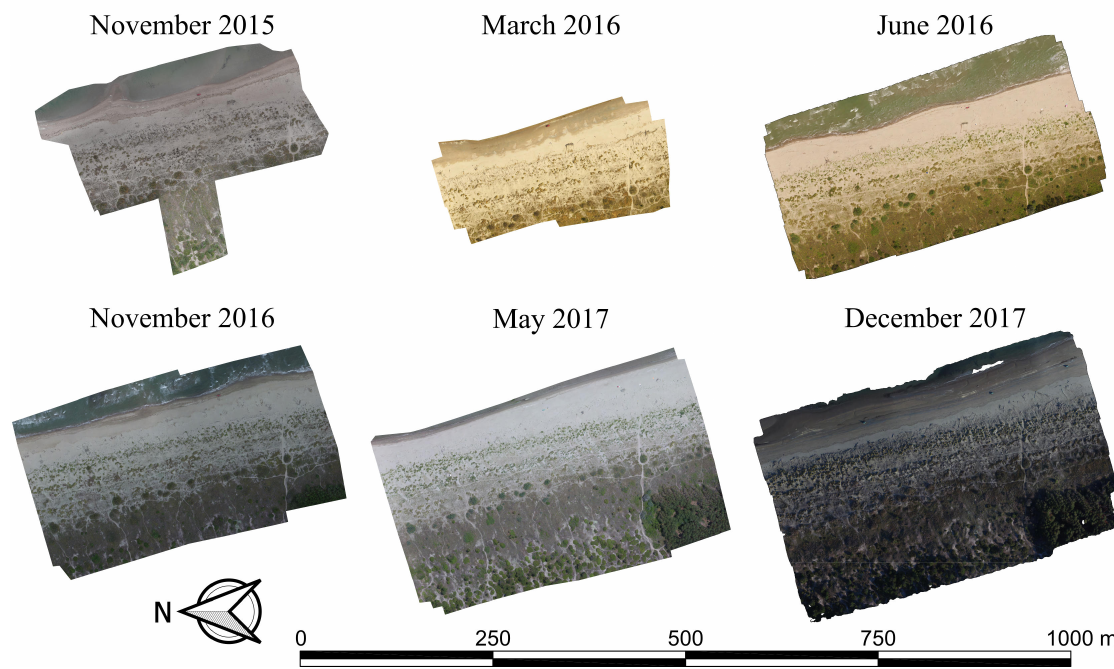
Figure 3. Orthomosaics of the six different survey repetitions from November 2015 to December 2017 showing the extent of the surveyed regions.